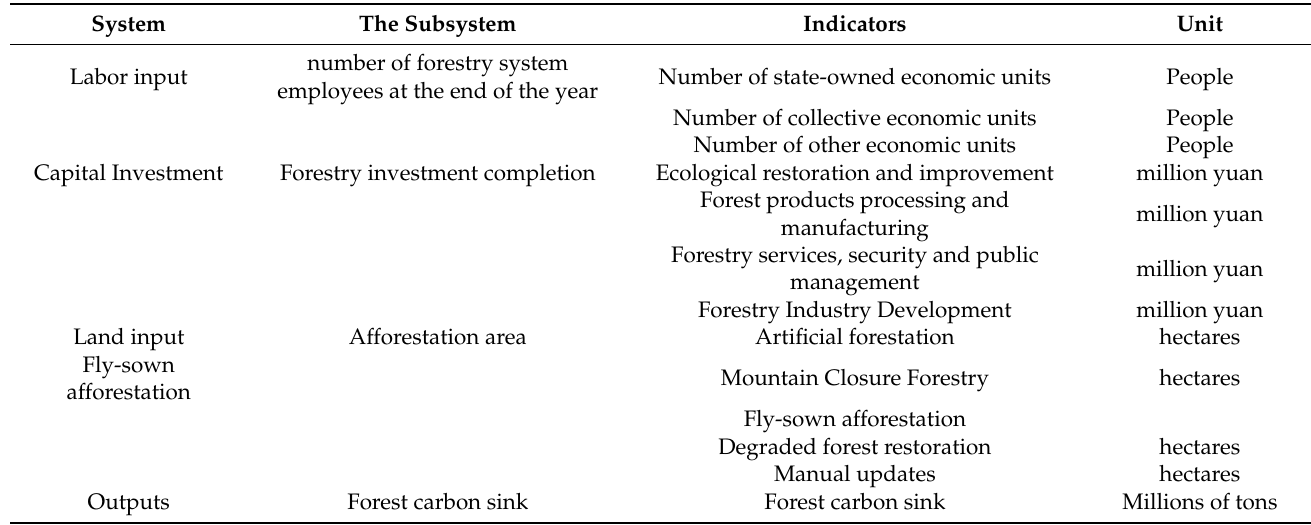
Table 1. Evaluation indicator system of forest carbon sinks development efficiency in